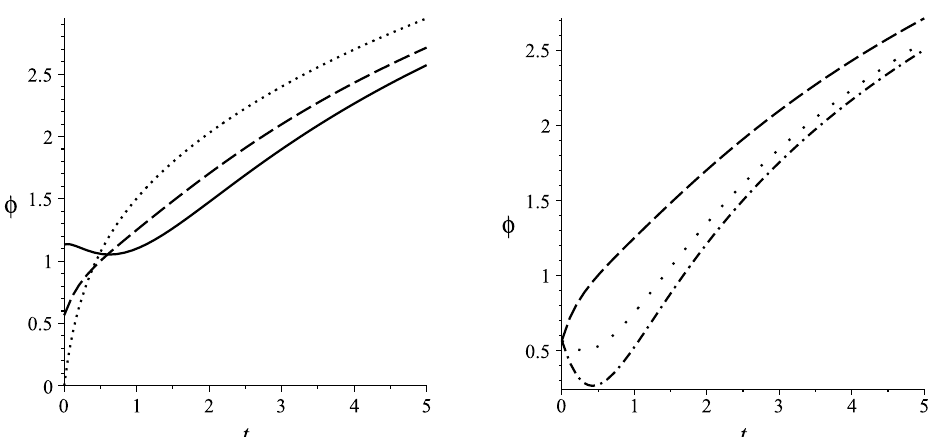
= 1 and C (cid:3) takes the values: 1 2 = 1 and C (cid:3) 2 1 = 3 (dash-dotted line). 1